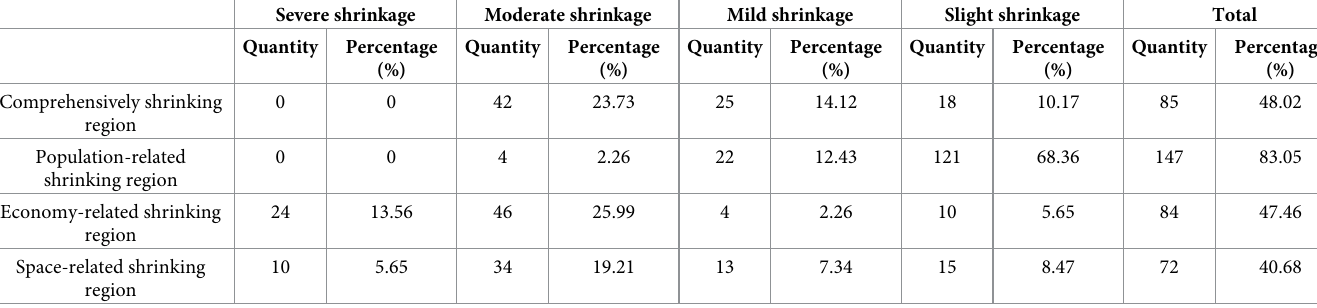
Table 3. Hierarchical statistics of regional shrinkage of the three northeastern provinces from 2012 to